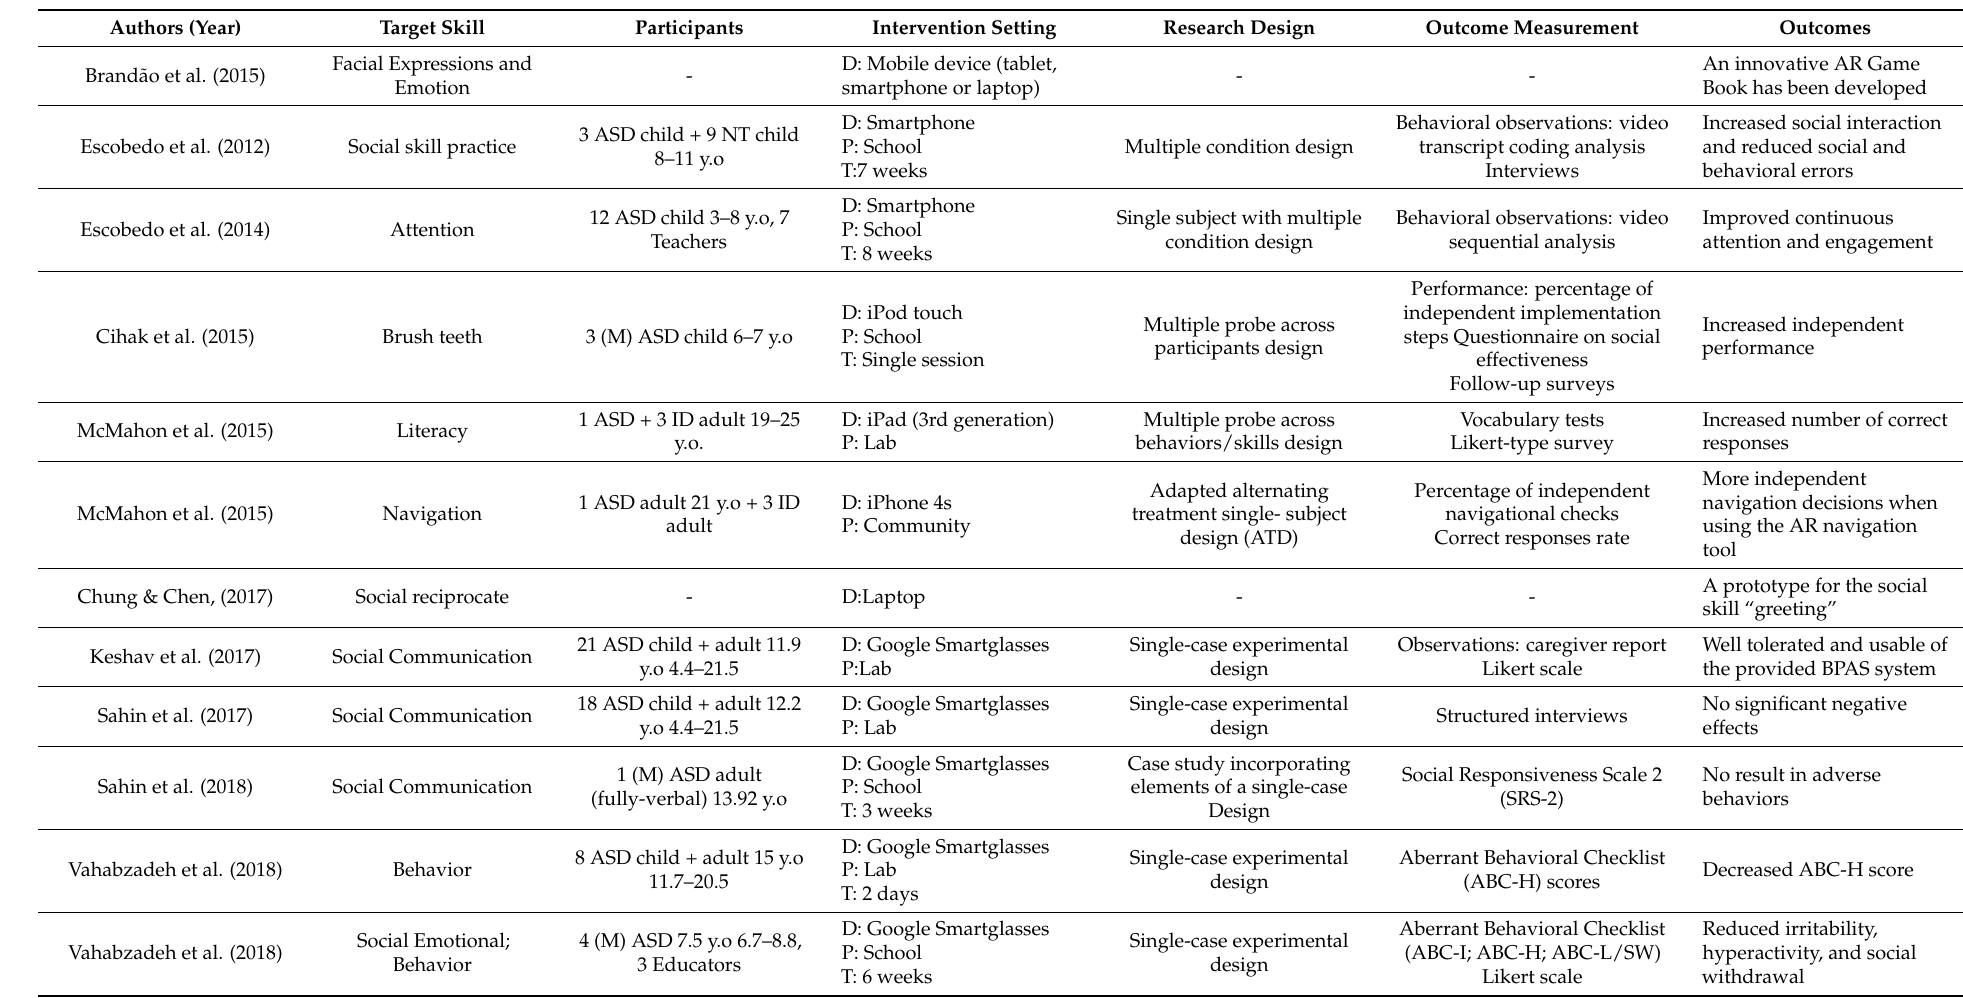
Table 4. Summary of selected studies ( n =